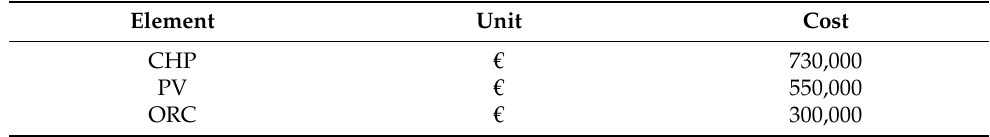
Table 3. Costs of components of systems adopted in